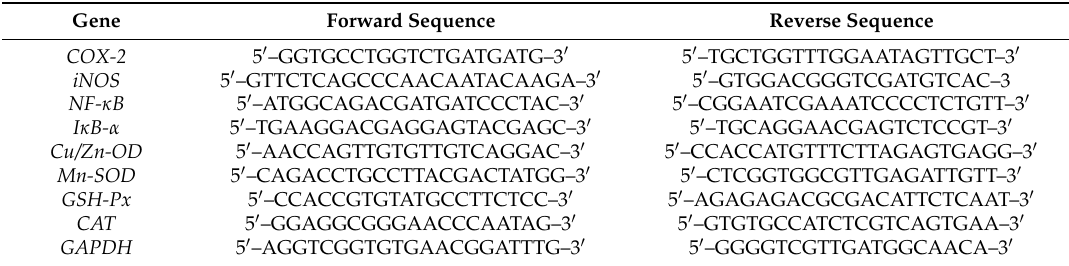
Table 2. qPCR assay